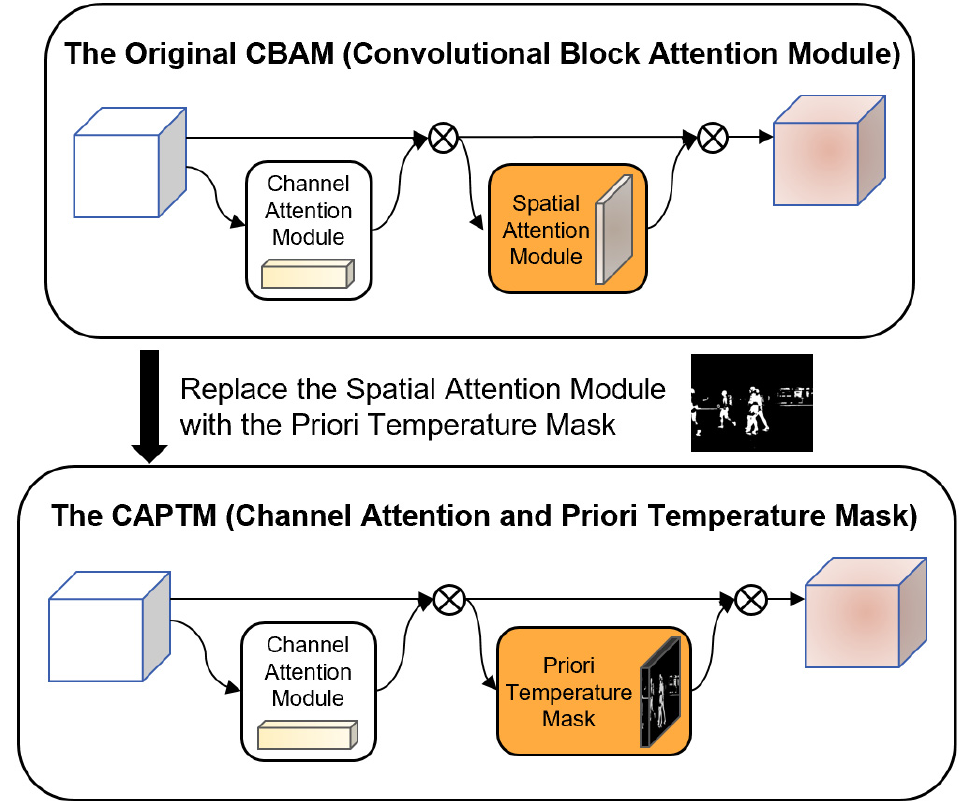
Figure 4. The convolution block attention module (CBAM) and channel attention and a priori temperature mask (CAPTM) module.